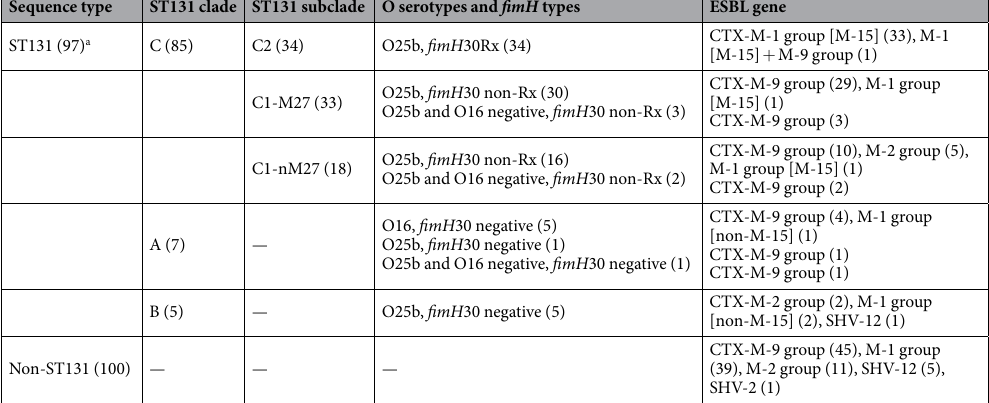
Table 3. Characteristics of the O25b, fimH 30 and ESBL genotypes in ESBL-producing E. coli used in this study a Numbers in parentheses indicate the number of